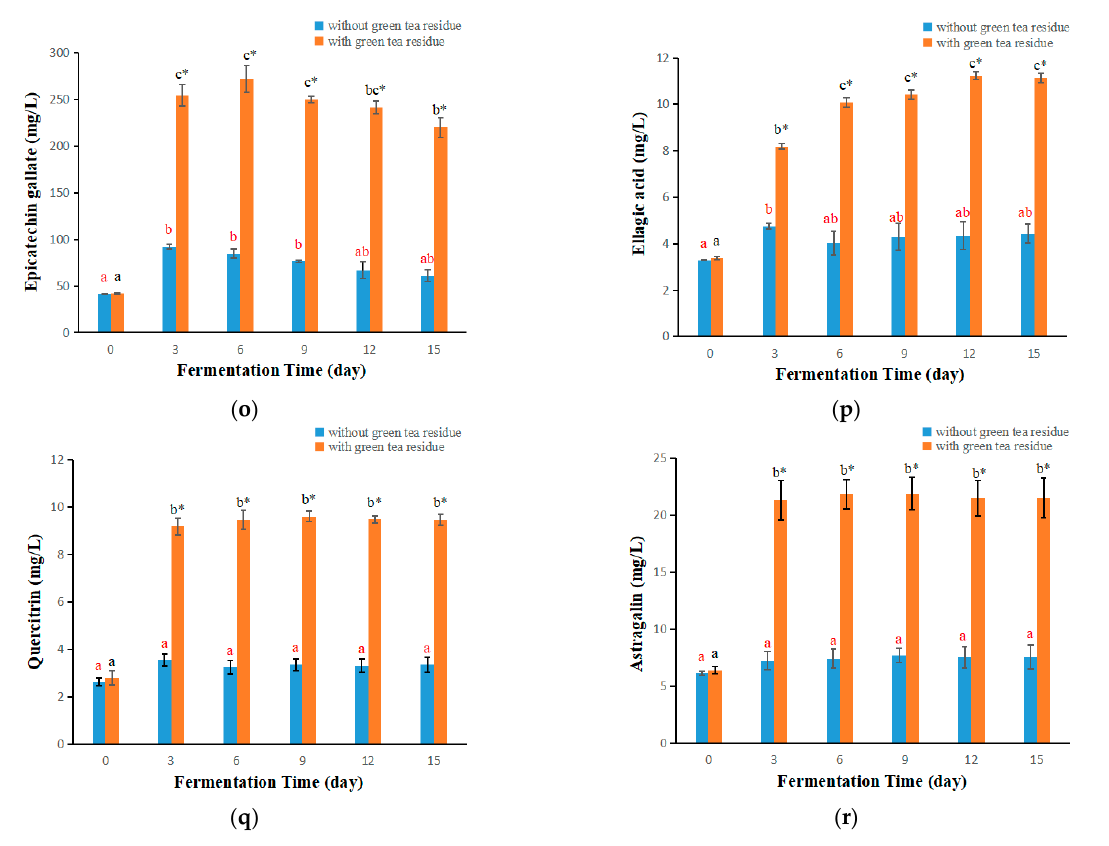
Figure 6. The changes of contents of main phenolic compounds and caffeine of kombucha produced by fermentation with or without black tea residue at different fermentation stages. ( a – h ) kombucha from black tea, and ( i – r ) kombucha from green tea. Different letters illustrate significant differences ( p < 0.05) for the same kombucha beverage at different fermentation times, and the same letter represents no significant difference ( p > 0.05). Different colors of letters represent different kombucha fermentation with tea residue or without tea residue. * Indicates significant difference ( p < 0.05) between kombucha fermentation with tea residue and kombucha fermentation without tea residue at the same fermentation